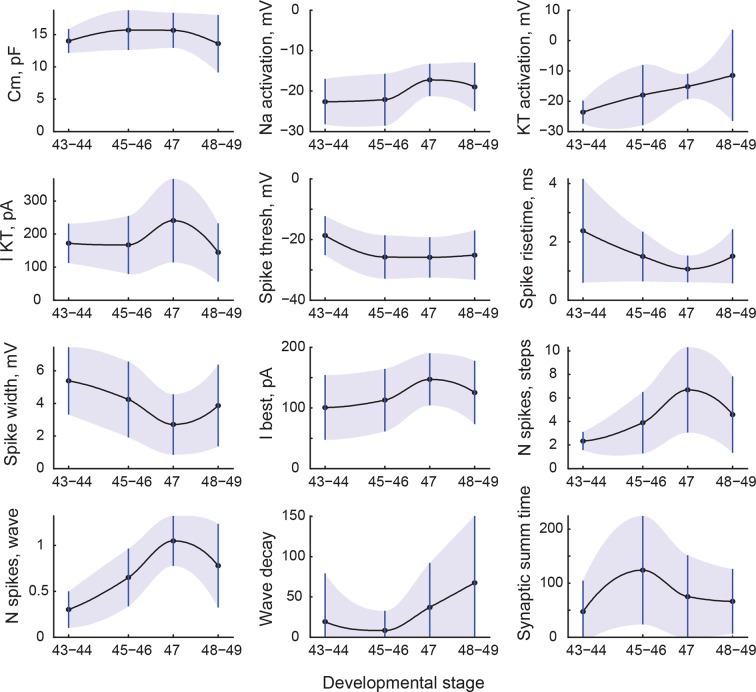
Changes in cell properties with age.All cell properties that significantly changed with development are shown here as mean values (central line) and standard deviations (whiskers and shading). Transitions between points are shown as shape-preserving piecewise cubic interpolations.